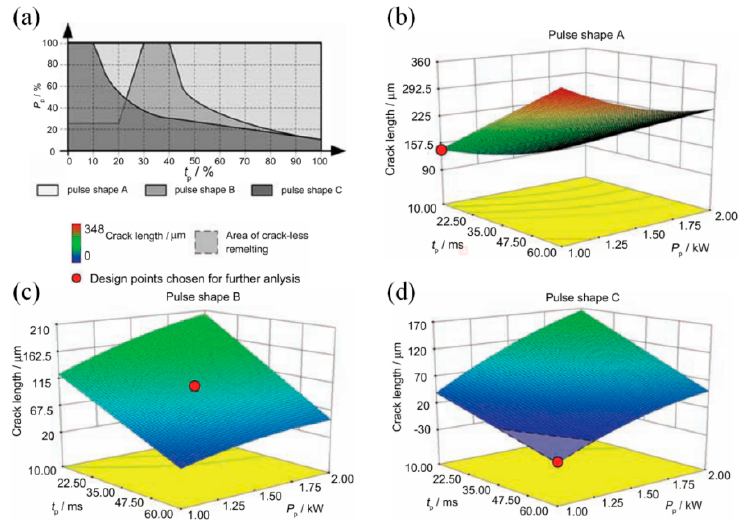
Figure 9. ( a ) Residual stress of Inconel 718 cladding creased by different parameters of PW laser (Reprinted from ref. [31], copyright (2014), with permission from Hindawi.); ( b )Residual stress of sub- strate and coating zone. (Reprinted from ref. [47], copyright (2021), with permission from Elsevier).